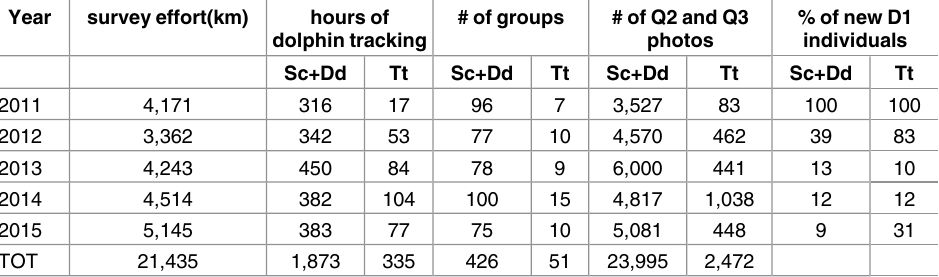
Table 2. Main characteristics of the dataset. Survey effort, hours of dolphintracking, number (#) of sam- pled groups, number (#) of high quality photos (Q2 and Q3) and percentage(%) of new identifiedindividuals by year and by species (Sc+Dd = striped and common dolphins; Tt = bottlenosedolphins)are